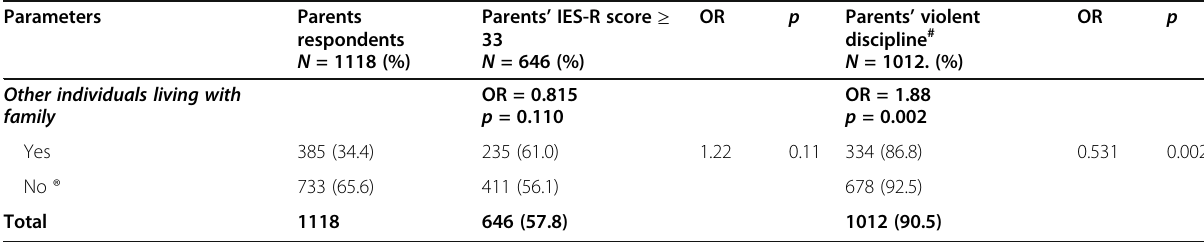
Table 1 Socio-demographic characteristics of survey respondents and their association with psychological impact of the pandemic on the parents and violent discipline against their children during the COVID-19 pandemic in Sohag governorate, Egypt, 2020 (Continued) Parameters